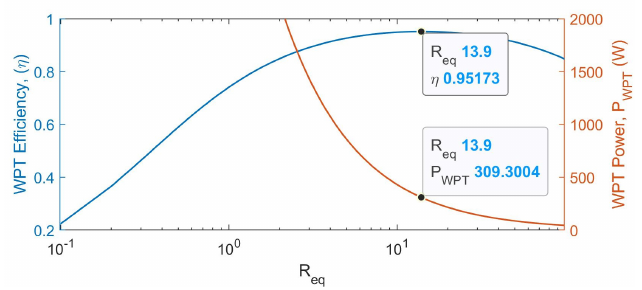
Figure 6. Efficiency, η vs. R eq and P wpt